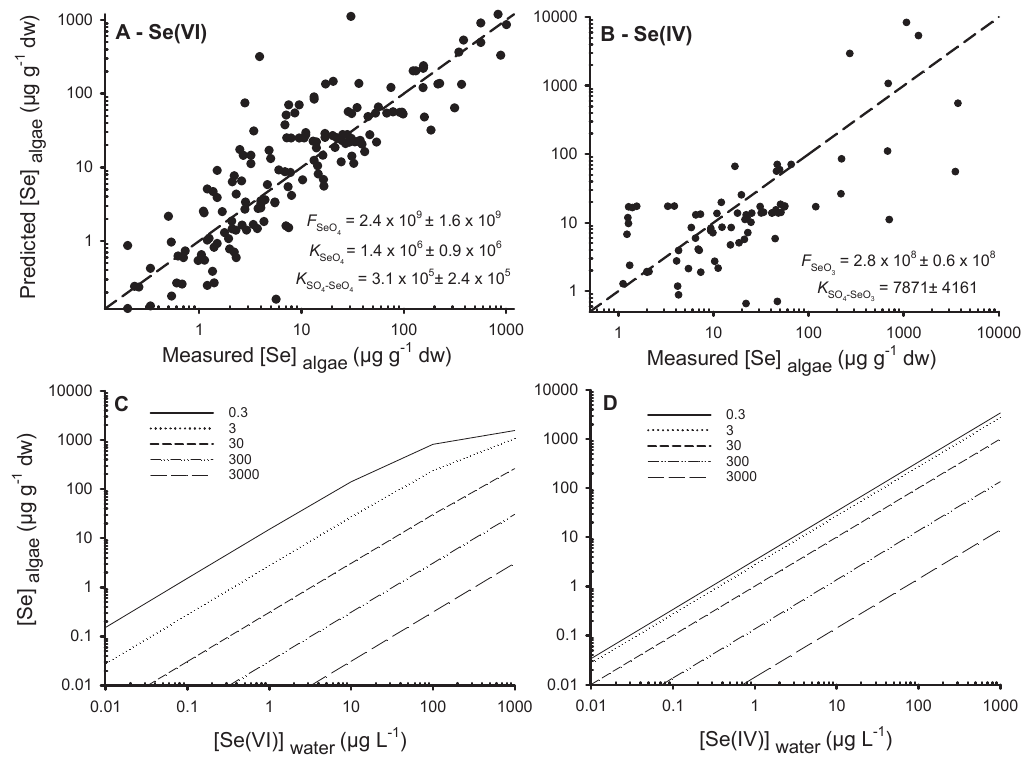
Figure 7. Predicted algae selenium concentrations (Predicted [Se] algae , µ g g − 1 dw) from the competition model (Equation (12)) of sulfate with ( A ) selenate (Se(VI)) and ( B ) selenite (Se(IV)) as a function of measured algae selenium concentrations (Measured [Se] algae , µ g g − 1 dw). The 1:1 lines and estimated constants ( ± standard errors) of the model (Equation (12)) have been shown. In ( C ) are the predicted [Se] algae ( µ g g − 1 dw, Equation (12)) as a function of fictitious selenate concentrations ([Se(VI)] water , µ g L − 1 ), ( D ) selenite concentrations ([Se(IV)] water , µ g L − 1 ) and sulfate concentrations (mg L − 1 ; in legend). Note that to use both models with the constants provided, SO 42 − , Se(IV) and Se(VI) concentrations must be in mol L − 1 and the output results are in µ g g − 1 dw.